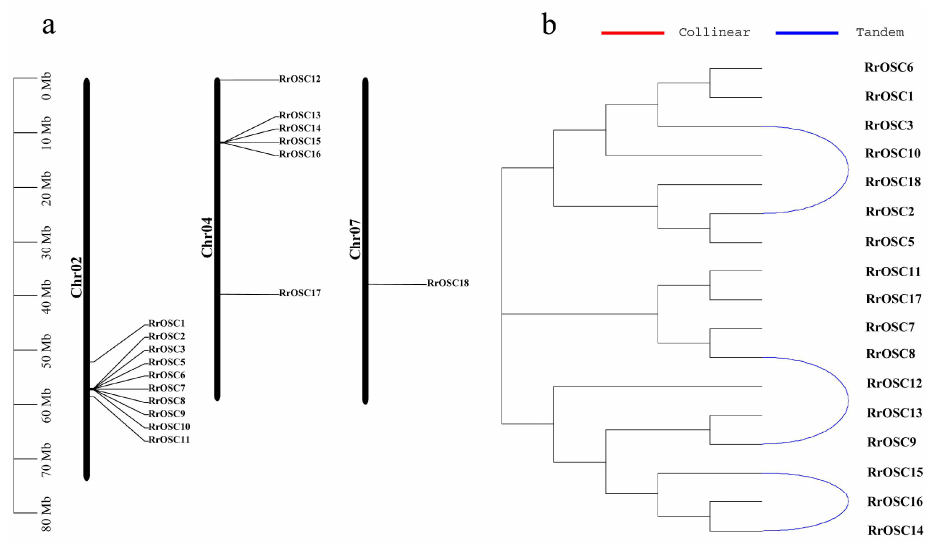
Figure 3. Chromosomal localization ( a ) and tandem duplication ( b ) analysis of RrOSCs . Blue lines indicated the duplication gene pairs according to the synteny analysis.